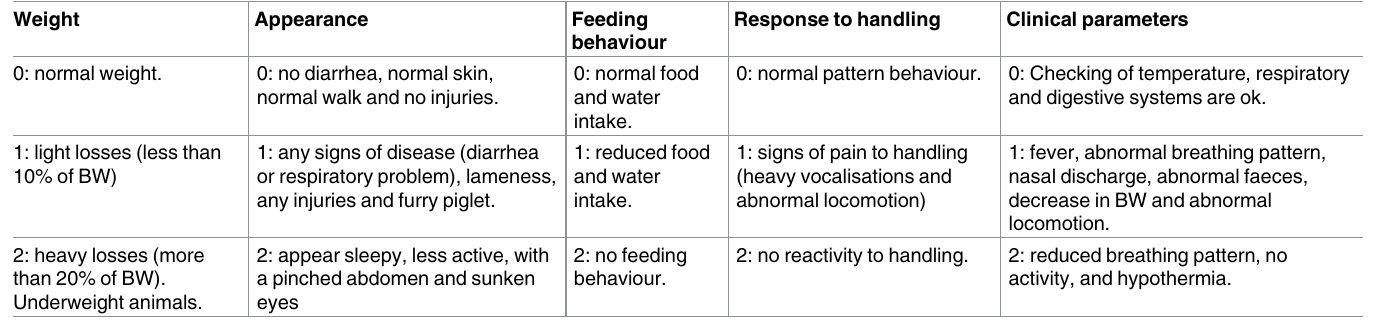
Table 2. Guidelines on the recognition of pain, distress and discomfort.